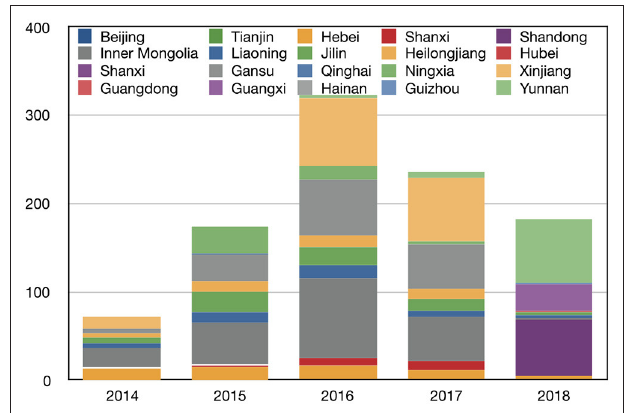
FIGURE 2 | Performance of wind power generation